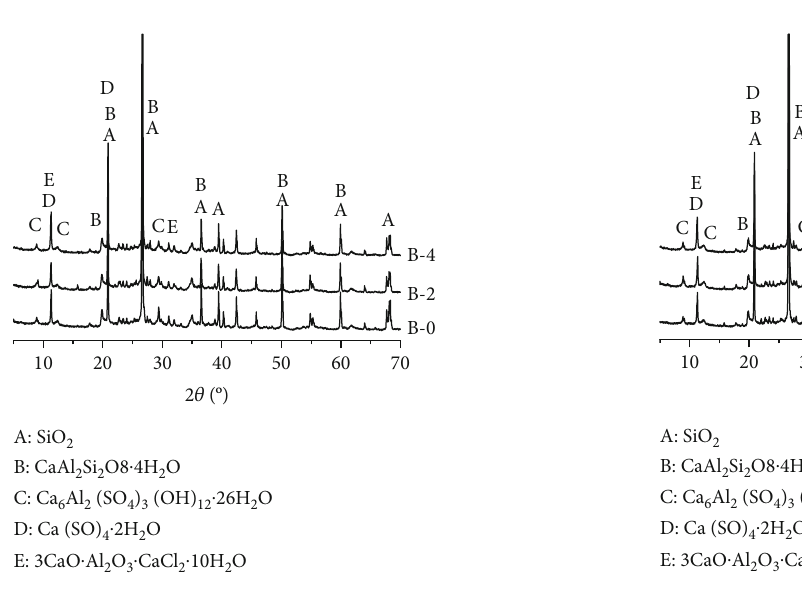
Figure 8: XRD energy spectrum of soil-cement at 60 d. Figure 9: XRD energy spectrum of soil-cement at 90d.